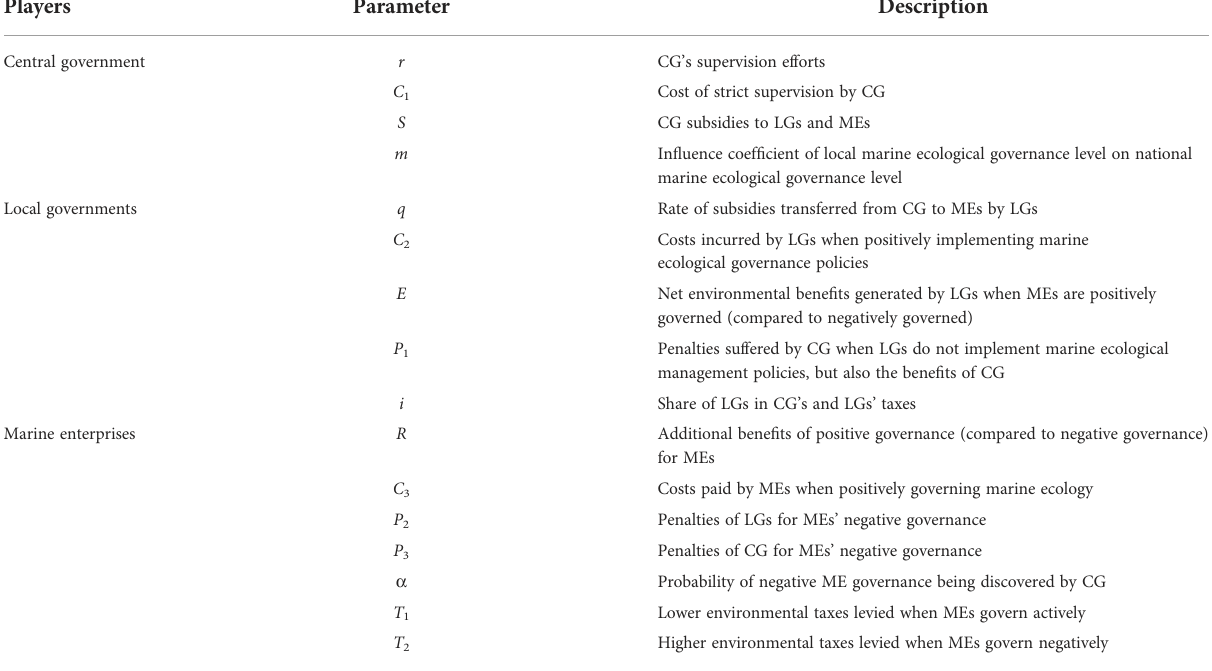
TABLE 1 Model parameters and expression